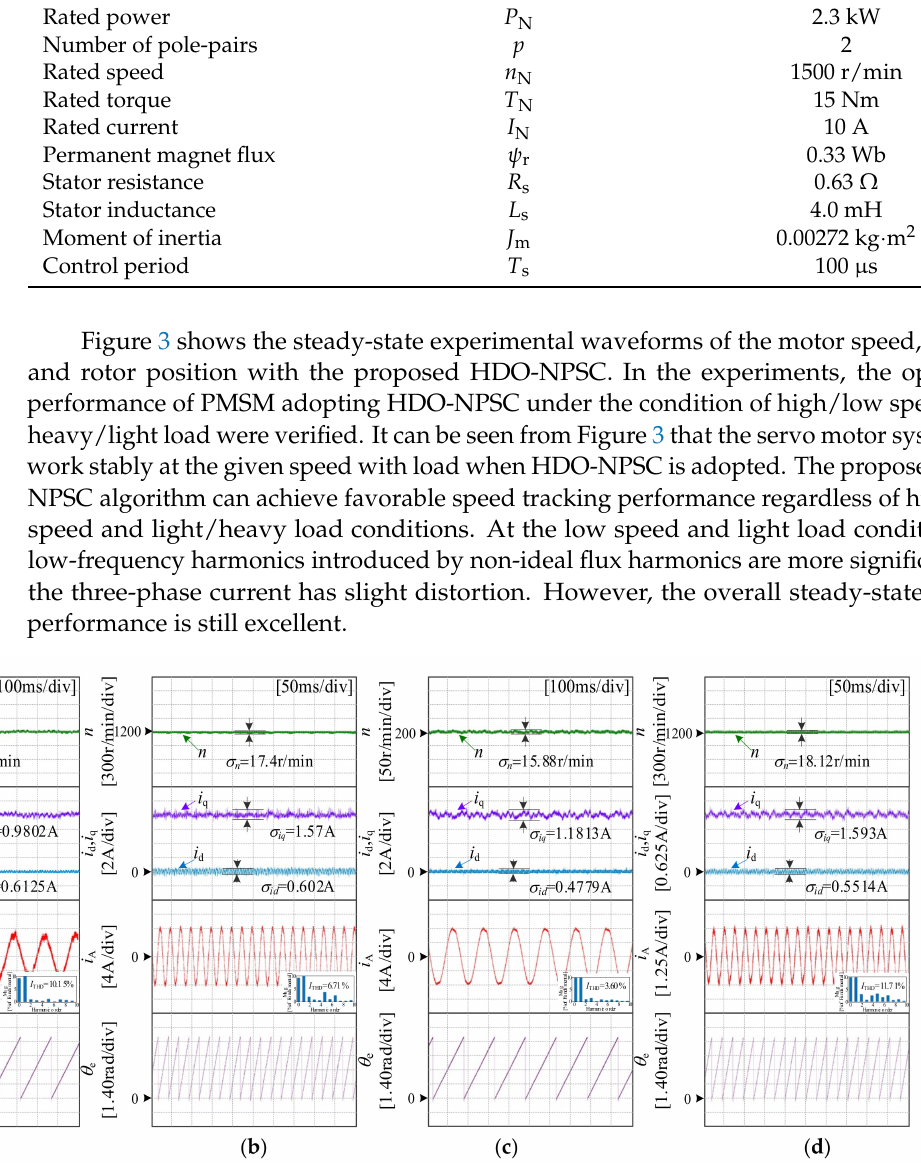
Figure 3. Experimental results of the proposed algorithm under the steady-state operation. ( a ) Low speed (200 r/min) with light-load condition (3.75 Nm). ( b ) High speed (1200 r/min) with heavy-load condition (12 Nm). ( c ) Low speed (200 r/min) with heavy-load condition (12 Nm). ( d ) High speed (1200 r/min) with light-load condition (3.75